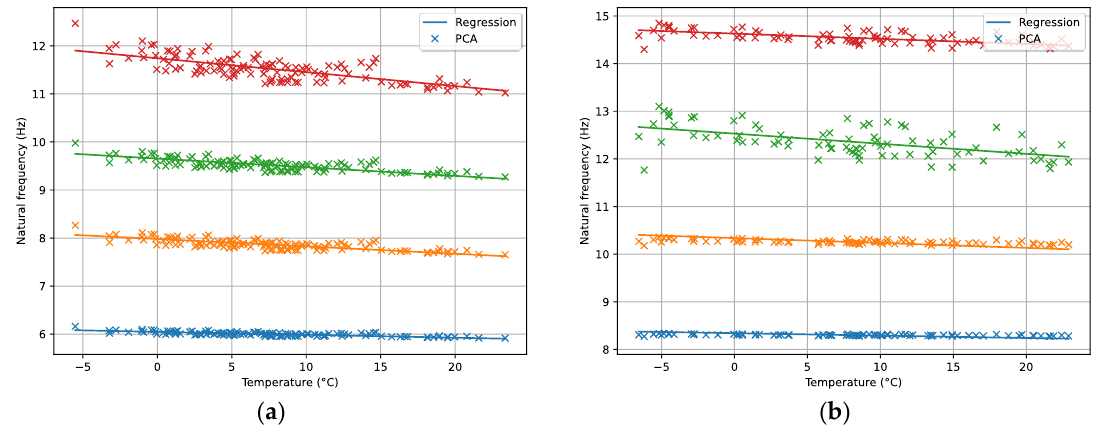
Figure 10. Temperature-dependent modes: ( a ) Seolmun Bridge; ( b ) Gajwa Bridge.